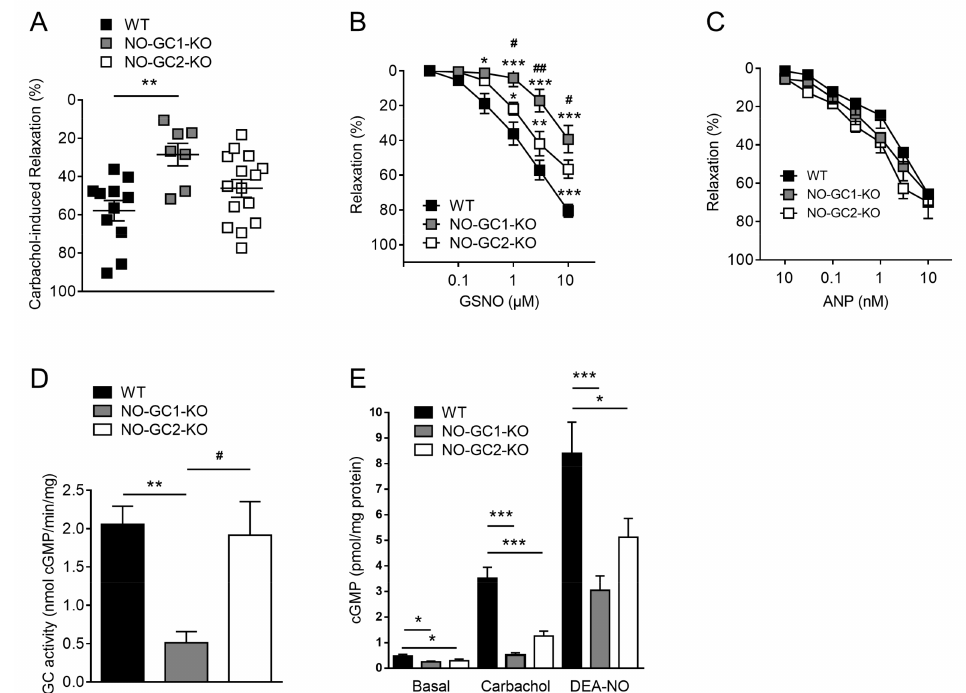
Figure 4. Impaired NO-mediated renal vasorelaxation in NO-GC1-KO and NO-GC2-KO mice. ( A ) Endothelial-dependent renal vasorelaxation by carbachol (30 µ M) was significantly reduced in isolated perfused kidneys of NO-GC1-KO compared to WT mice; ( B ) Smooth muscle cell-dependent vasorelaxation induced by the NO donor GSNO was significantly attenuated in isolated perfused kidneys of NO-GC1-KO ( n = 8) and NO-GC2-KO ( n = 13) compared to WT ( n = 11) mice; ( C ) Atrial natriuretic peptide (ANP)-induced renal vasorelaxation did not differ between WT ( n = 6), NO-GC1-KO ( n = 10) and NO-GC2-KO ( n = 5) mice; ( D ) Renal NO-GC activity was significantly decreased in NO-GC1-KO ( n = 6) compared to WT ( n = 19) and NO-GC2-KO ( n = 7) mice; ( E ) Renal cGMP levels at baseline, in response to carbachol (30 µ M) or DEA-NO (100 µ M) were significantly decreased in NO-GC1-KO (10 slices of n = 3) and NO-GC2-KO (11 slices of n = 3) compared to WT (10 slices of n =